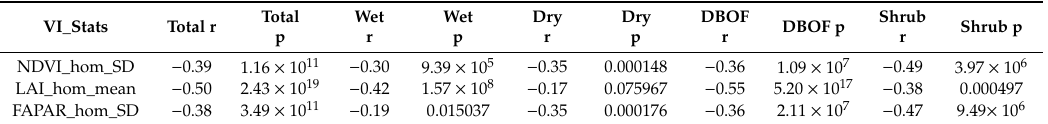
Figure 3. Selected scatterplots showing the distribution of observations by dominant land cover types, and the relationship between SWI and key VI statistics for the 28 samples sites across the Delta. Only the top-performing statistics (in terms of r values) are shown here. Green indicates observations with DBOF as dominant vegetation and yellows are for shrubs. The grey lines display the confidence interval at 0.95. In each panel: ( a ) Correlating NDVI, NDWI, and FAPAR mean to SWI; ( b ) Correlating LAI mean, LAI entropy mean and SD to SWI. Table 3. Remaining top performing statistics (in terms of r values) describe the second-order homogeneity (mean and SD) that are not illustrated in Figures 2 and